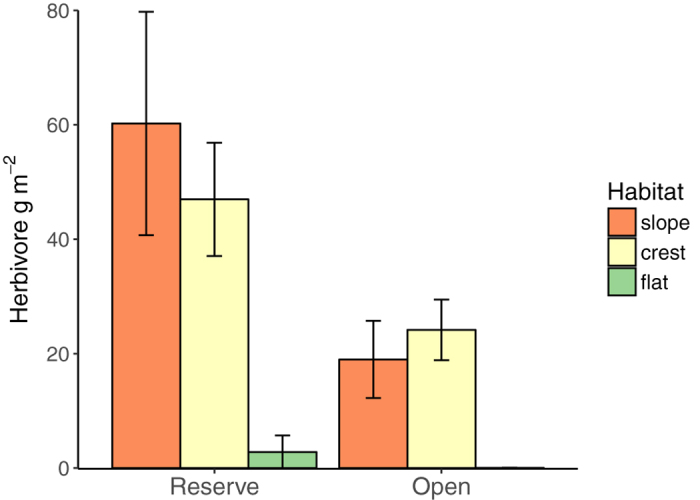
Mean herbivorous fish biomass (gm−2) across habitats and management types.Error bars represent standard error of the mean (s.e.m.).